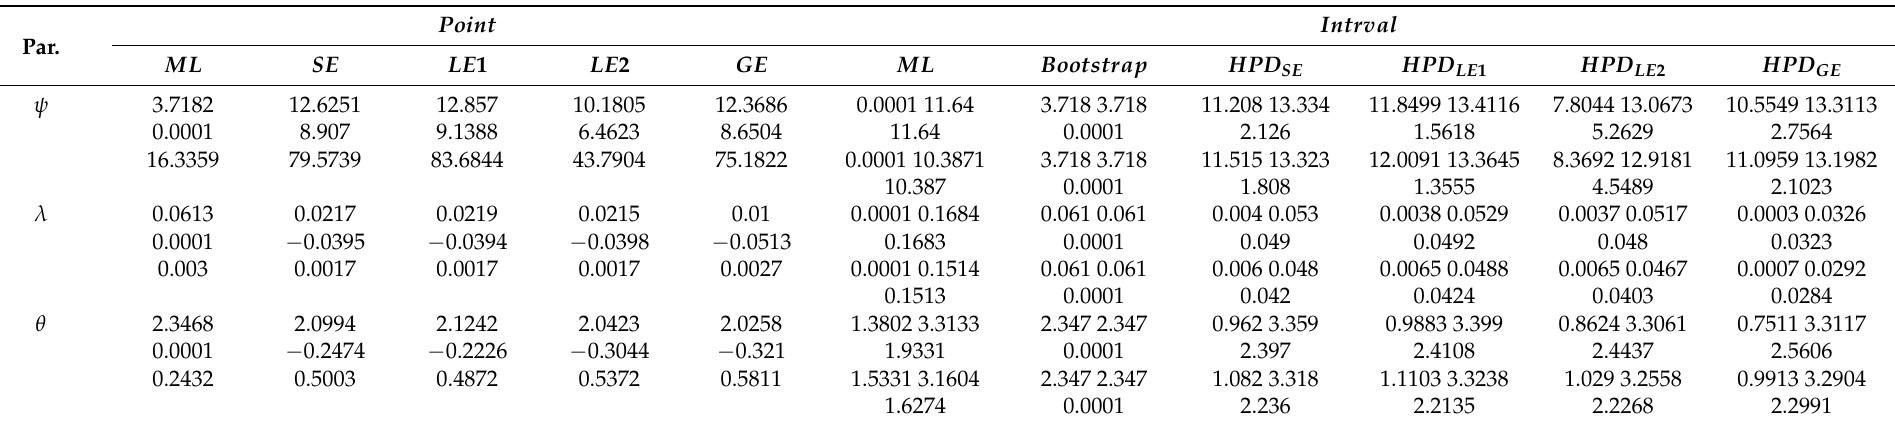
Table 5. The estimation of the parameters ψ , λ , and θ for the high